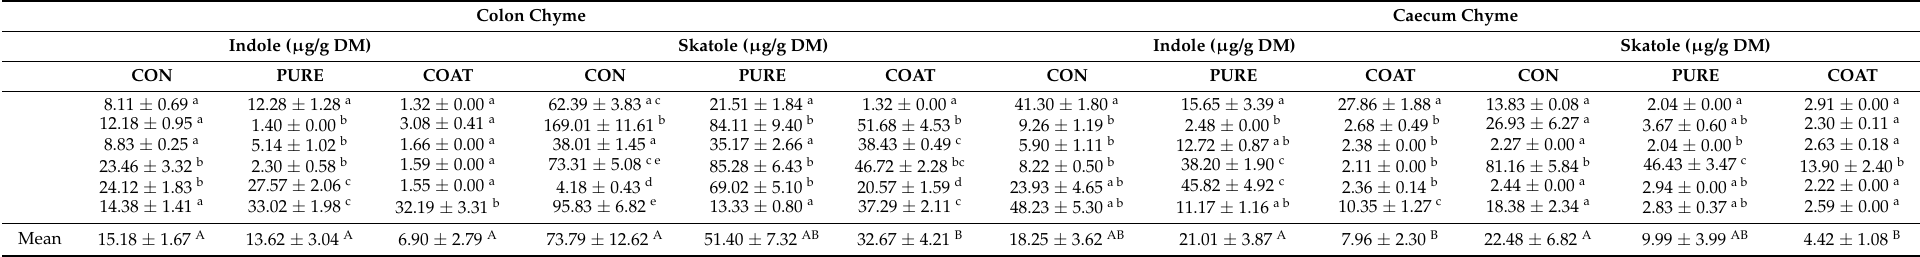
Different superscript lowercase letters in a column indicate significant differences between either indole or skatole content in either colon or caecum chyme of animals of one feeding group. Different upper-case letters in the row ‘mean’ for either indole or skatole content of either colon or caecum chyme indicate significant differences between feeding groups. Significant differences were determined using One-Way ANOVA and Tukey test ( p <